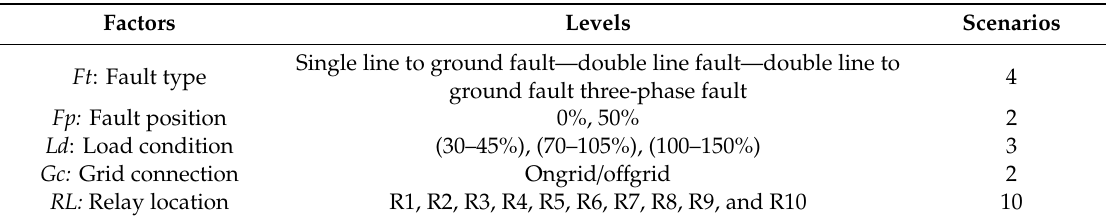
Table 10. Factors for the sensitivity